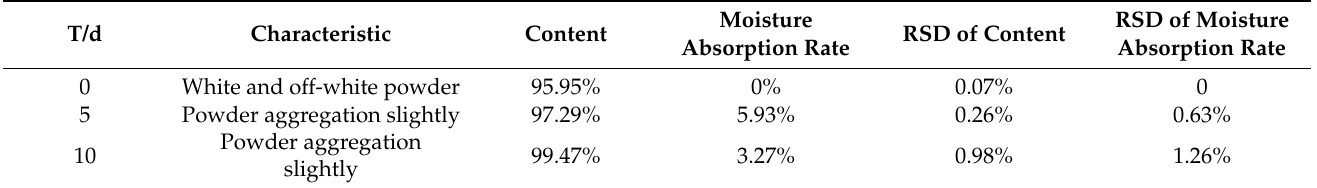
Table 7. The characteristic and moisture absorption under high humidity (saturated NaCl solution, RH 75% ±